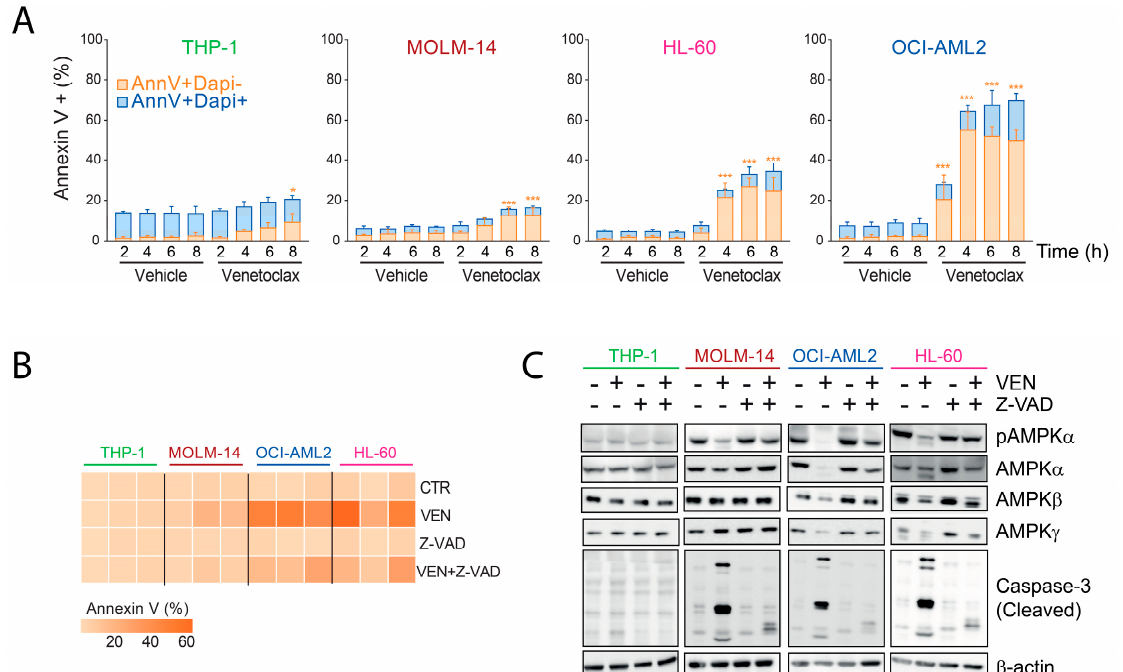
Figure 3. AMPK degradation is due to on-target caspase activation by venetoclax. ( A ) AML cell lines were incubated with 100 nM venetoclax during the indicated times and processed for flow cytometry using annexin V and DAPI staining. Annexin V-positive and DAPI-negative cells are those in early apoptosis, while double positivity indicates either late apoptosis or necrotic cells. The experiment was repeated three times separately. Vertical bars indicate standard deviations. * p < 0.05, *** p < 0.001. ( B , C ) AML cell lines were incubated with vehicle (CTR), 100 nM venetoclax (VEN), 50 µM Z-VAD (pan-caspase inhibitor) or a combination of 50 µM Z-VAD (added 24 h before VEN) and 100 nM venetoclax for 4 h. ( B ) Flow cytometry measurement of annexin V binding done in three separate experiments and plotted in a heat-map format. ( C ). Western blots done using anti-phospho-AMPK T172, -AMPK α , β , γ , -cleaved caspase 3, and – β -actin.